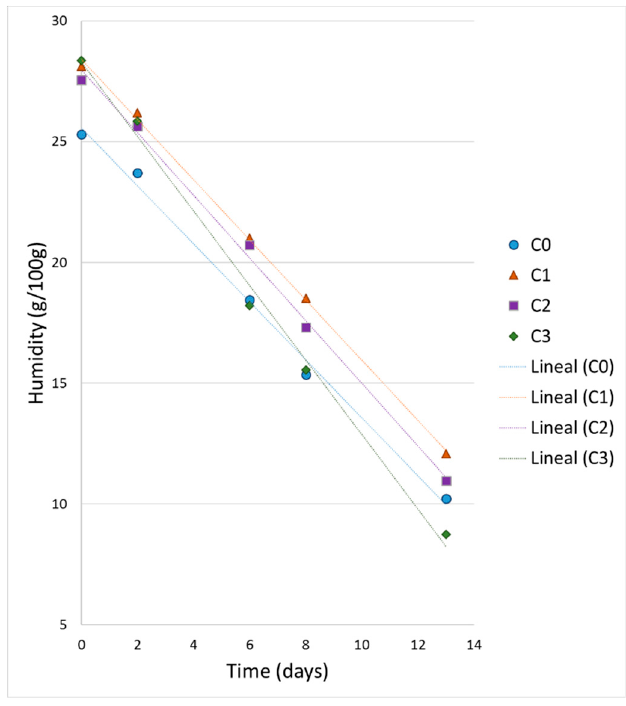
Figure 3. Moisture variation of cupcake samples over time.